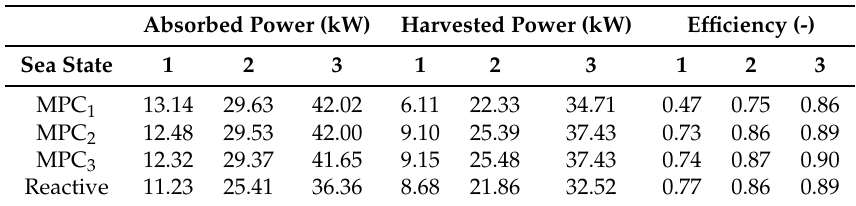
Table 3. Average absorbed power, harvested power and efficiency for three different sea states for different WPEAs.